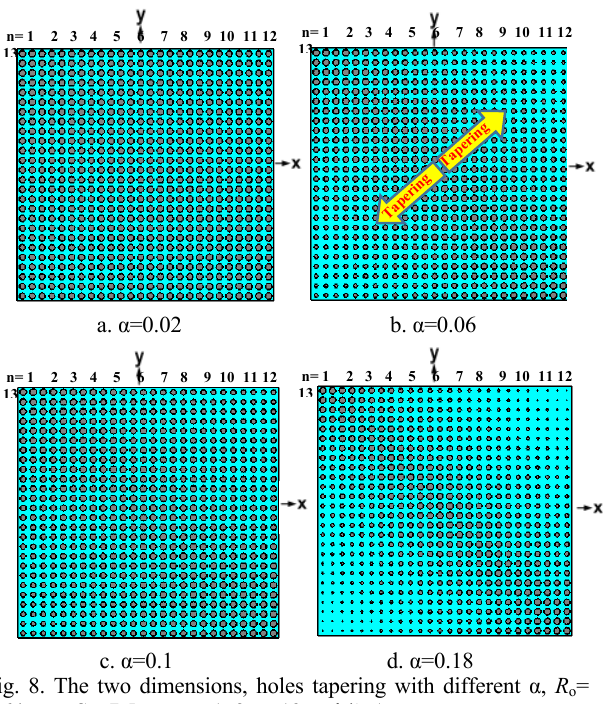
Fig. 8. The two dimensions, holes tapering with different α, R o = 2.64 mm, S p =7.5 mm, n =1, 2…, 13 and ζ =1.